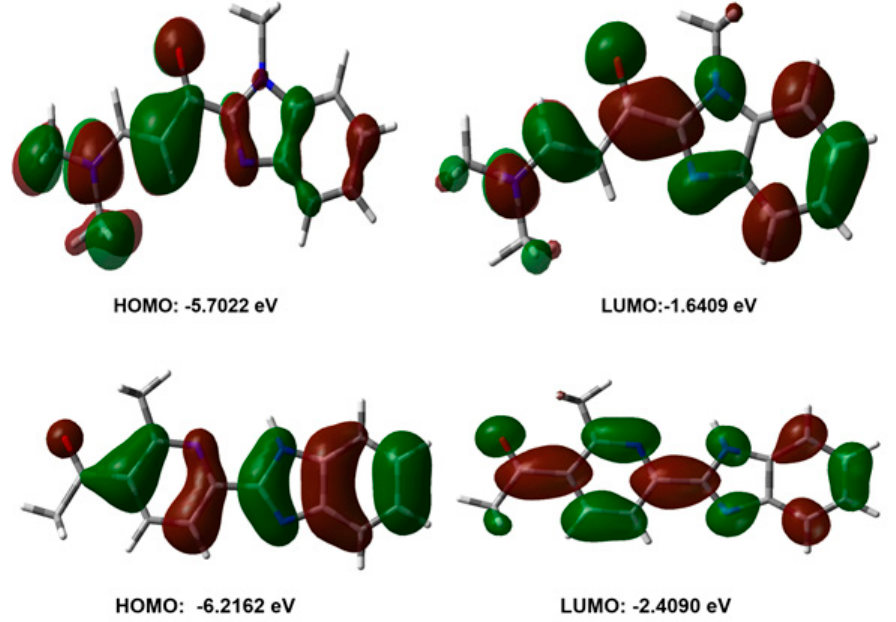
Figure 9. HOMO and LUMO orbital density of the N -methyl - β -enaminone 2 ( upper ) and compound 3 ( down ).